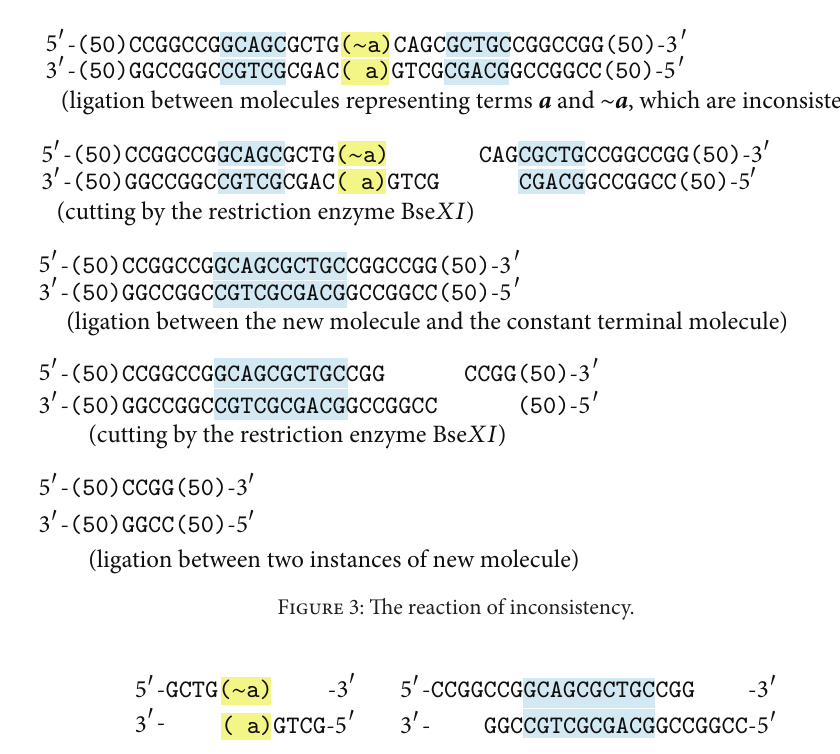
Figure 3: The reaction of inconsistency.